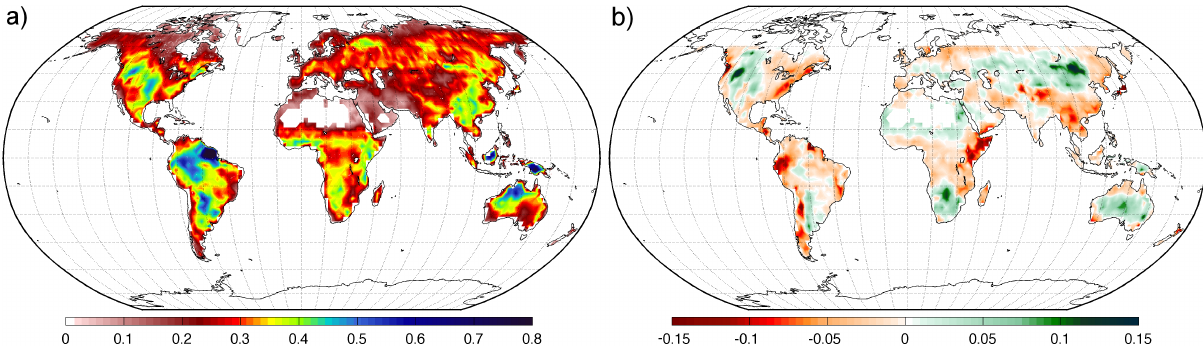
Fig. 3. Results of the triple collocation error analyses: (a) absolute error of the evaporation anomalies of GLEAM expressed as RMSE, (b) difference between the RMSE of the evaporation anomalies of GLEAM when it is run with CMORPH and when it is run with GPCP- 1DD (red colour represents the areas where using CMORPH improves the evaporation product). Units are mmday − 1